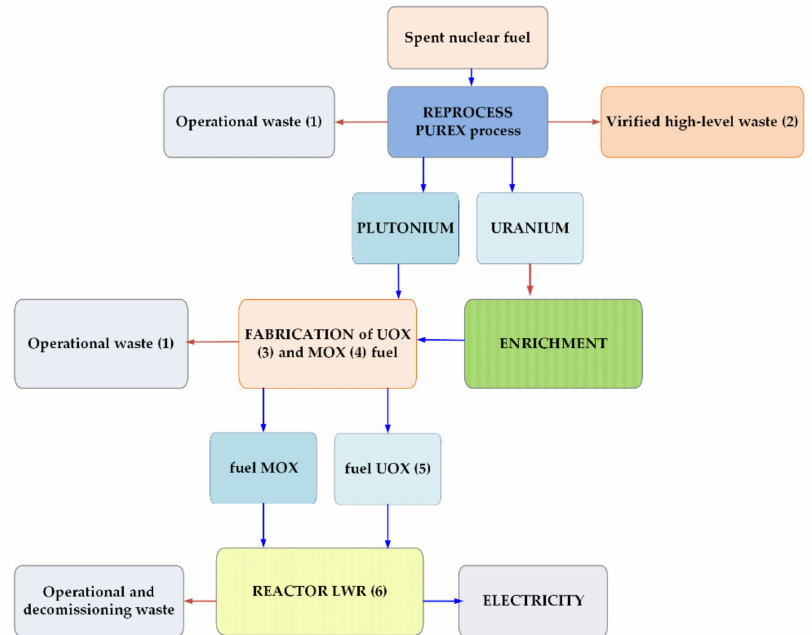
Figure 7. Reprocessing with reuse of uranium and plutonium. ( 1 ) Operational waste; ( 2 ) virified high-level waste; ( 3 ) uranium dioxide (UOX) fuel; ( 4 ) metal oxide (MOX) fuel; ( 5 ) fuel made of uranium dioxide; ( 6 ) light water reactor (LWR). Table 6. Global MOX fuel fabrication capacity (t/year).